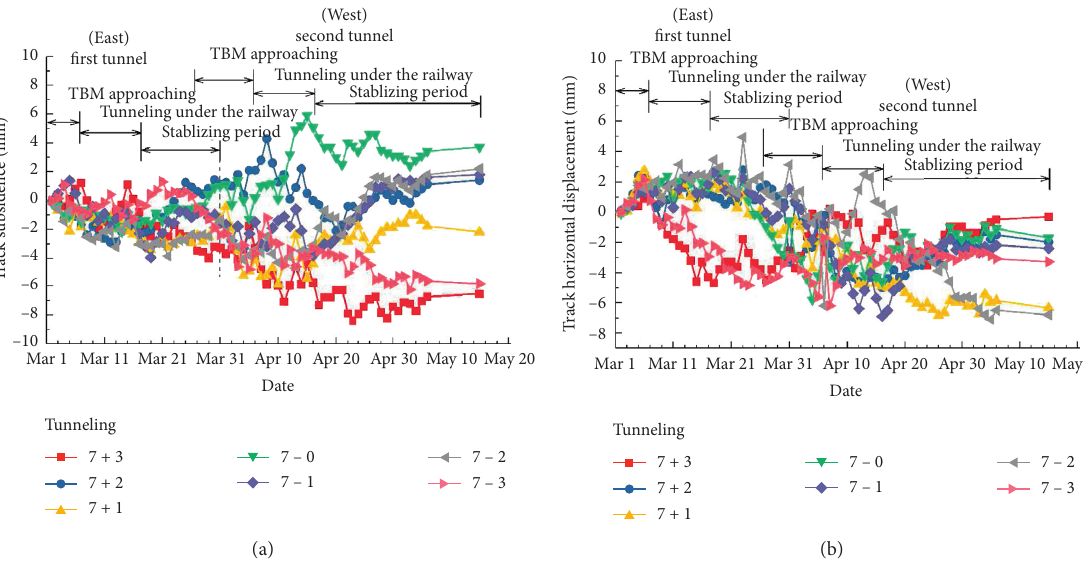
Figure 12: Monitored track displacement during tunnel advancement. (a) Track subsidence. (b) Horizontal track